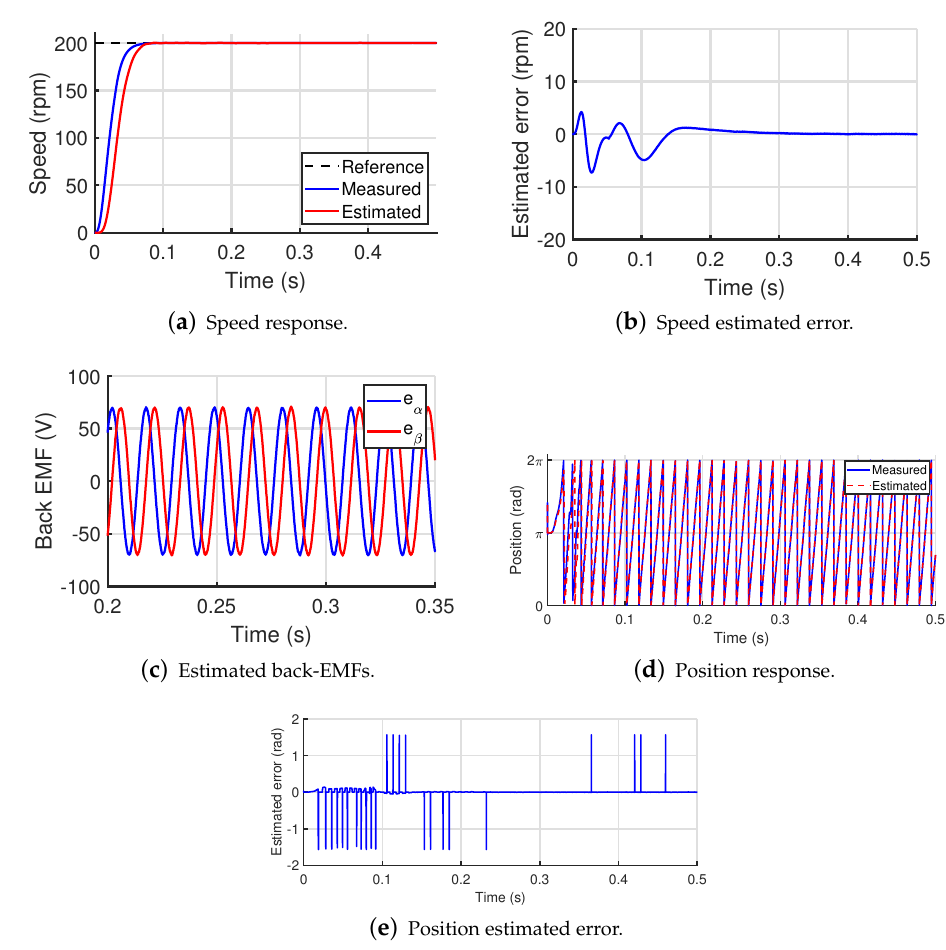
( e ) Position estimated error. Figure 3. Simulation results of the proposed observer under nominal parameters. Figures 7 and 8 respectively show the speed response and estimation error with differ- ent resistance values. The fluctuations in the estimated speed and the estimated disturbance are much increased compared to other parameter-mismatched situations, especially when the resistance increases, where the f d and f q rise to 10 V and 5 V, respectively. The speed estimates and disturbance estimates when the stator inductance and resistance change simultaneously are given in Figures 9 and 10. From these Figures, it can be observed that the proposed observer can still track the reference signal quickly and accurately even if the parameters are